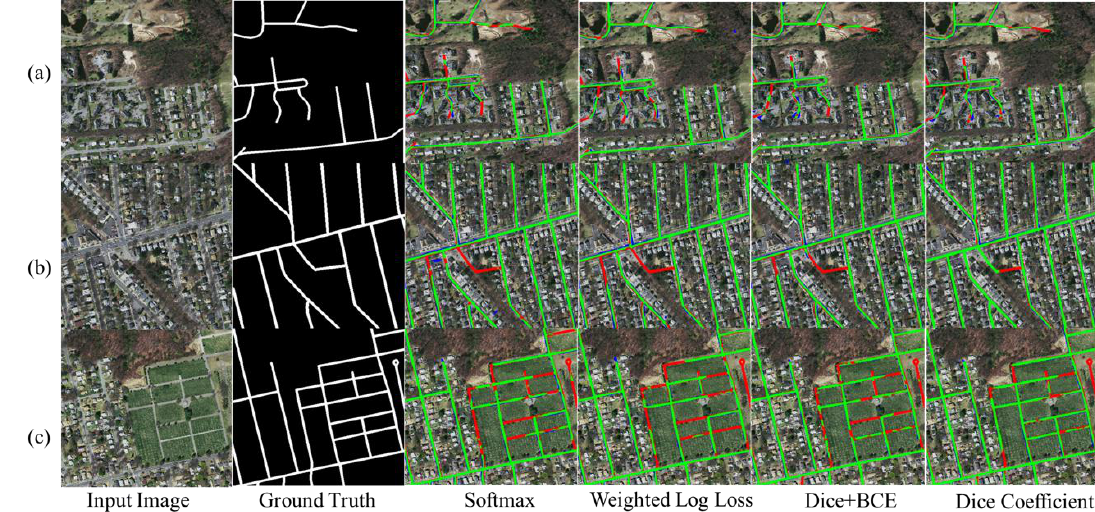
Figure 8. Magnification of the results in Figure 7. True positive (TP) is marked as green, false positive (FP) as blue, and false negative (FN) as red. Each subfigure in this figure is the magnification of the results shown in Figure 7. Table 2. Quantitative comparison of four loss functions for the testing dataset.